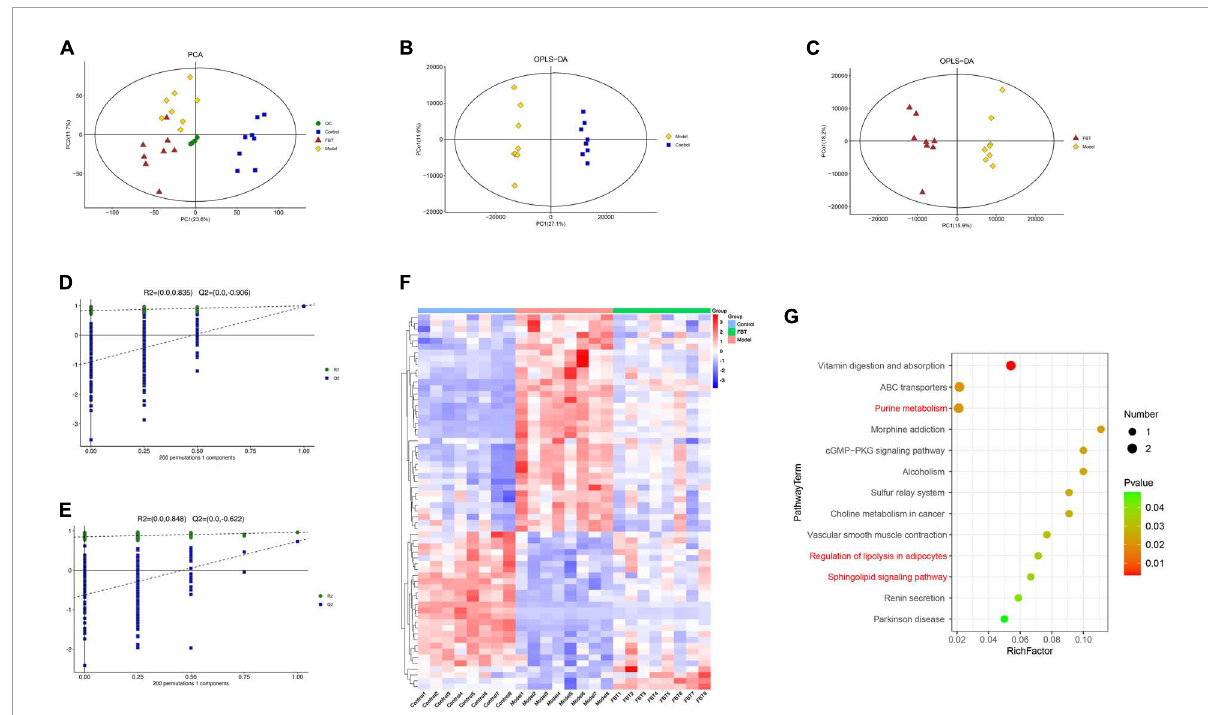
FIGURE6 Effects of FBT on the metabolic profile of the liver of NAFLD mice. (A) Scores plots of PCA between each group; (B) scores plots of OPLS-DA of LC-MS (Model vs. Control); (C) scores plots of OPLS-DA of LC-MS (FBT vs. Model); (D) permutation of OPLS-DA model (Model vs. Control); (E) permutation of OPLS-DA model (FBT vs. Model); (F) differentially abundant metabolites between each group; (G) analysis of metabolic pathway enrichment about differentially abundant